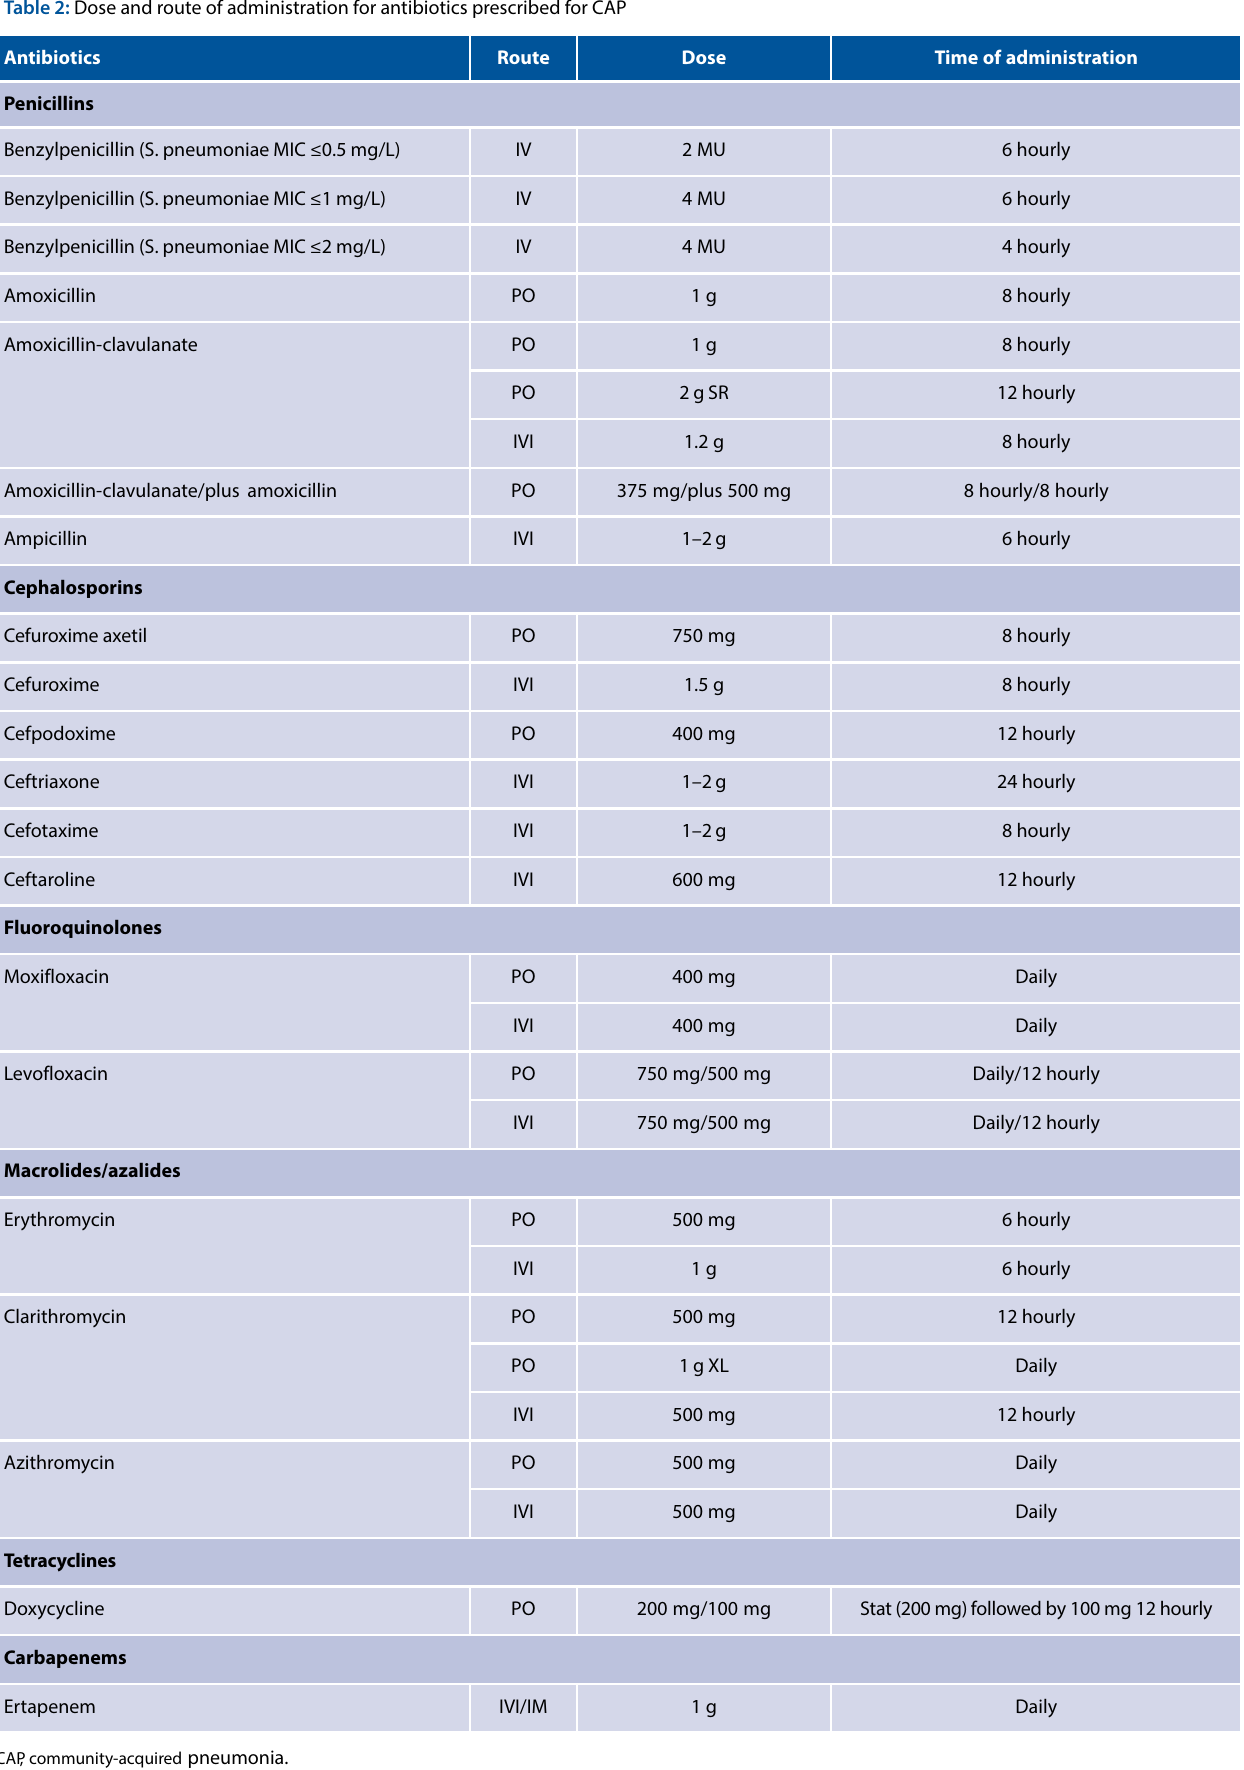
Table 2: Dose and route of administration for antibiotics prescribed for CAP Antibiotics Route Dose Time of administration